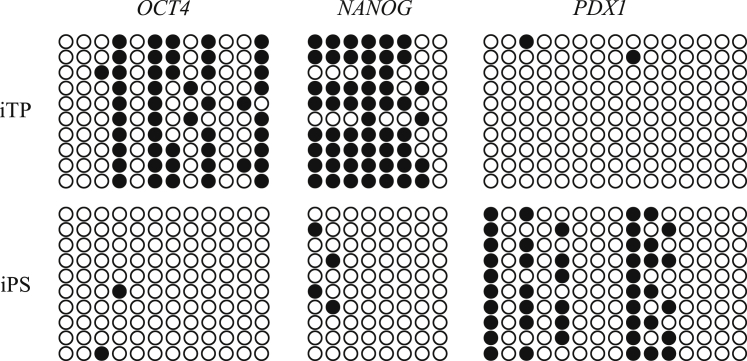
Bisulfite Sequence Analysis of Genomic DNABisulfite sequence analysis of the OCT4, NANOG, and PDX1 promoter regions in iTP05 cells and iPSCs. Open and closed circles indicate unmethylated and methylated CpG dinucleotides, respectively.